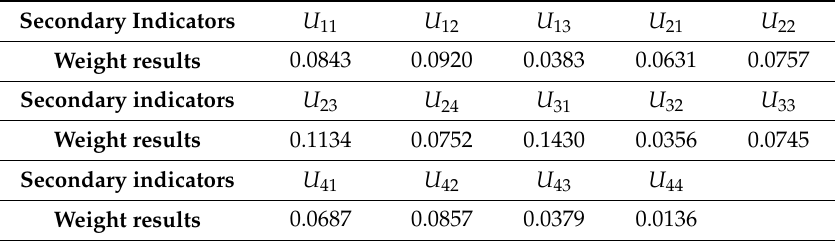
Table 3. Analytic network process (ANP) weight results of the secondary